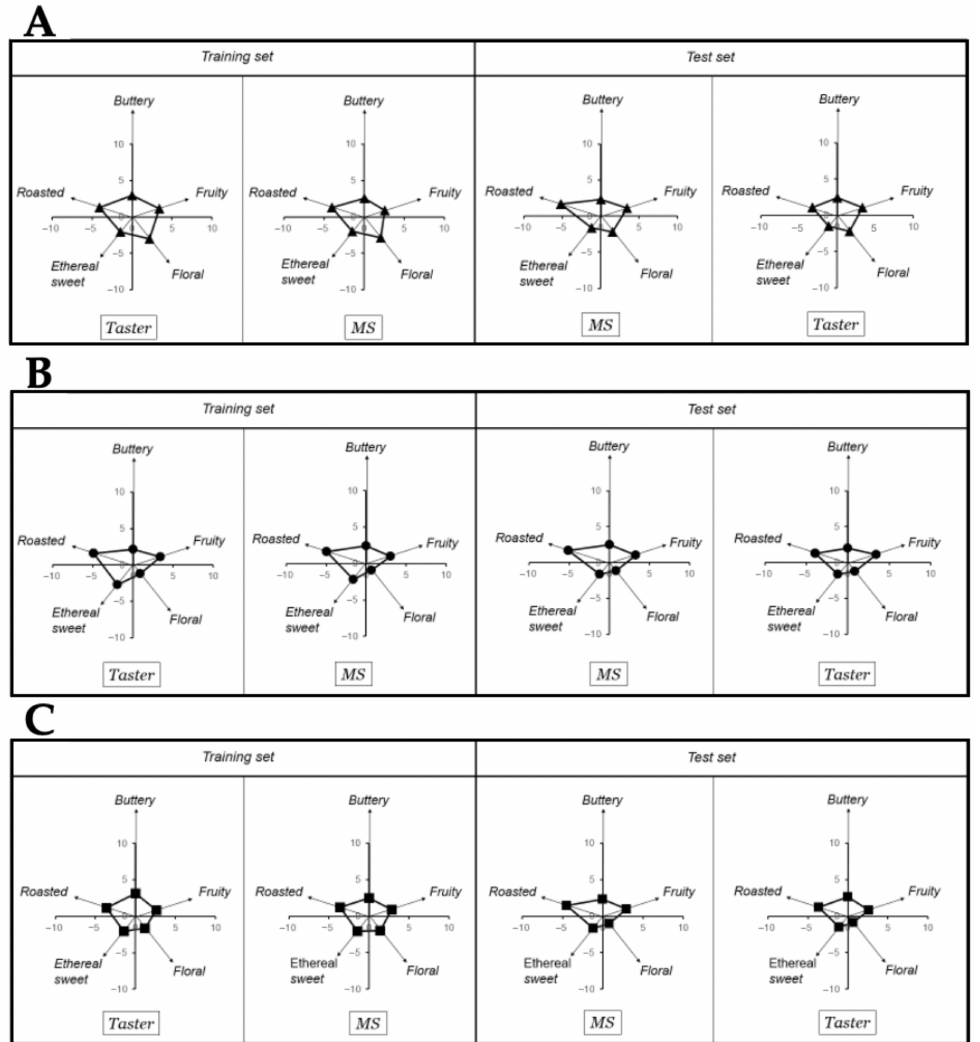
Figure 3. Training and test set of taster results in ( A ) bitter chocolate (70% cocoa), ( B ) nibs chocolate (70% cocoa), and ( C ) milk chocolate (50% cocoa) produced with northern Peru FFC